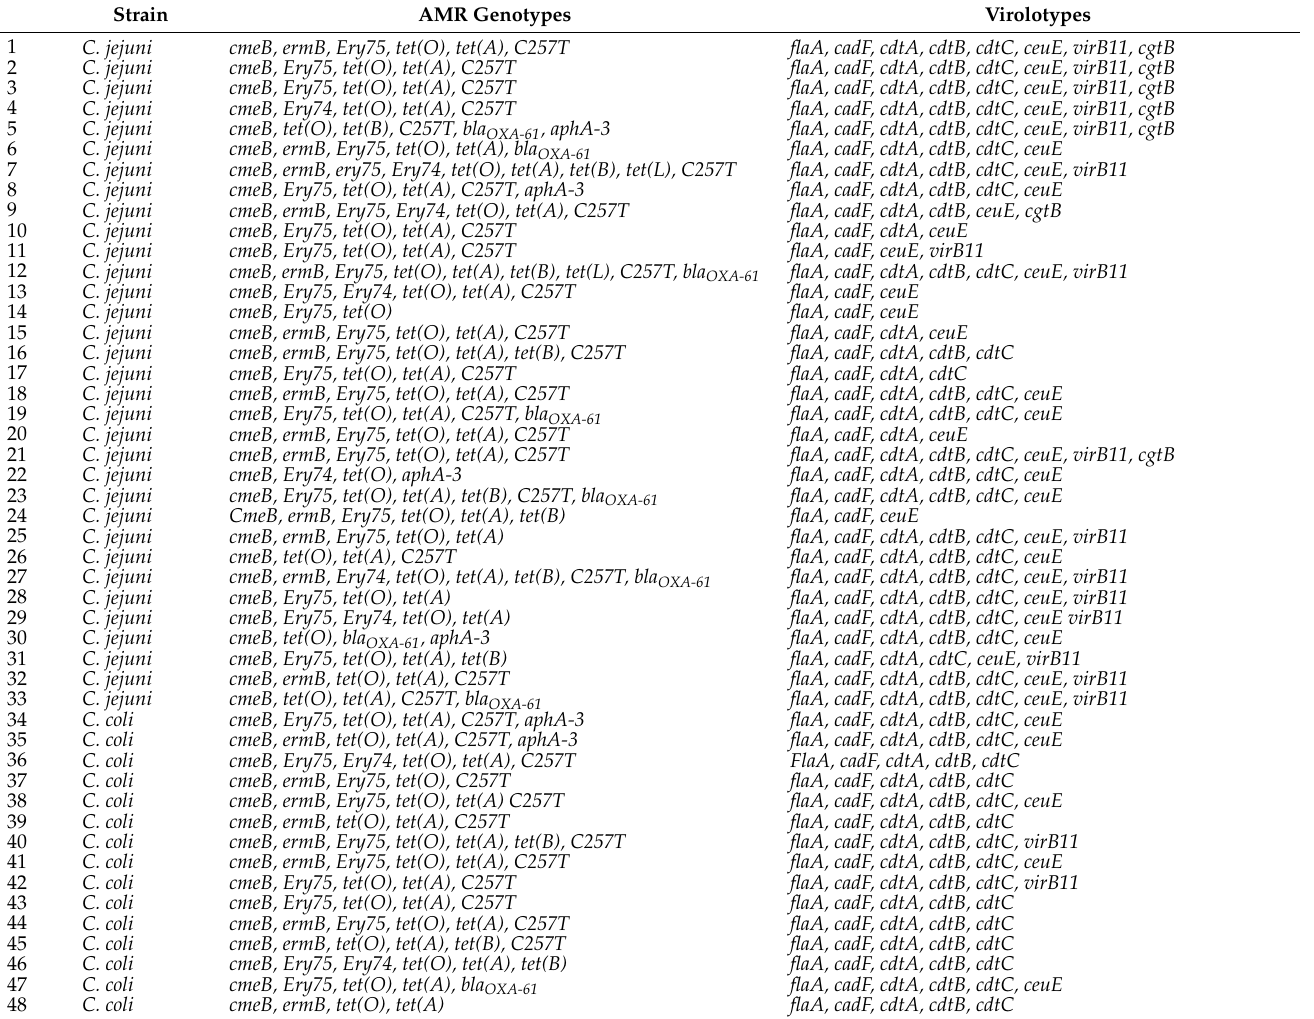
Table 4. AMR determinants and virulence profiles of Campylobacter